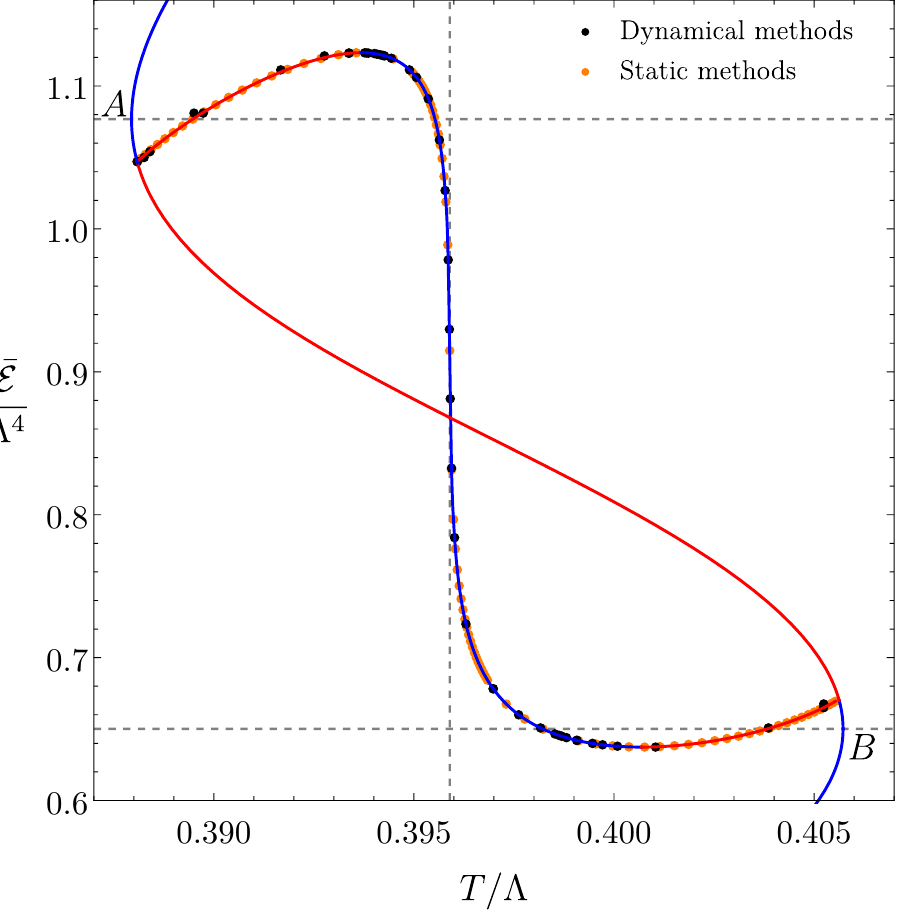
Figure 23 . Average energy density versus temperature for static inhomogeneous solutions obtained with dynamical methods (black dots) and with static methods (orange dots) for a system with ˆ L ’ 11 . 501849 . Blue (red) curves indicate locally stable (unstable) solutions. Orange dots are exactly as in figure